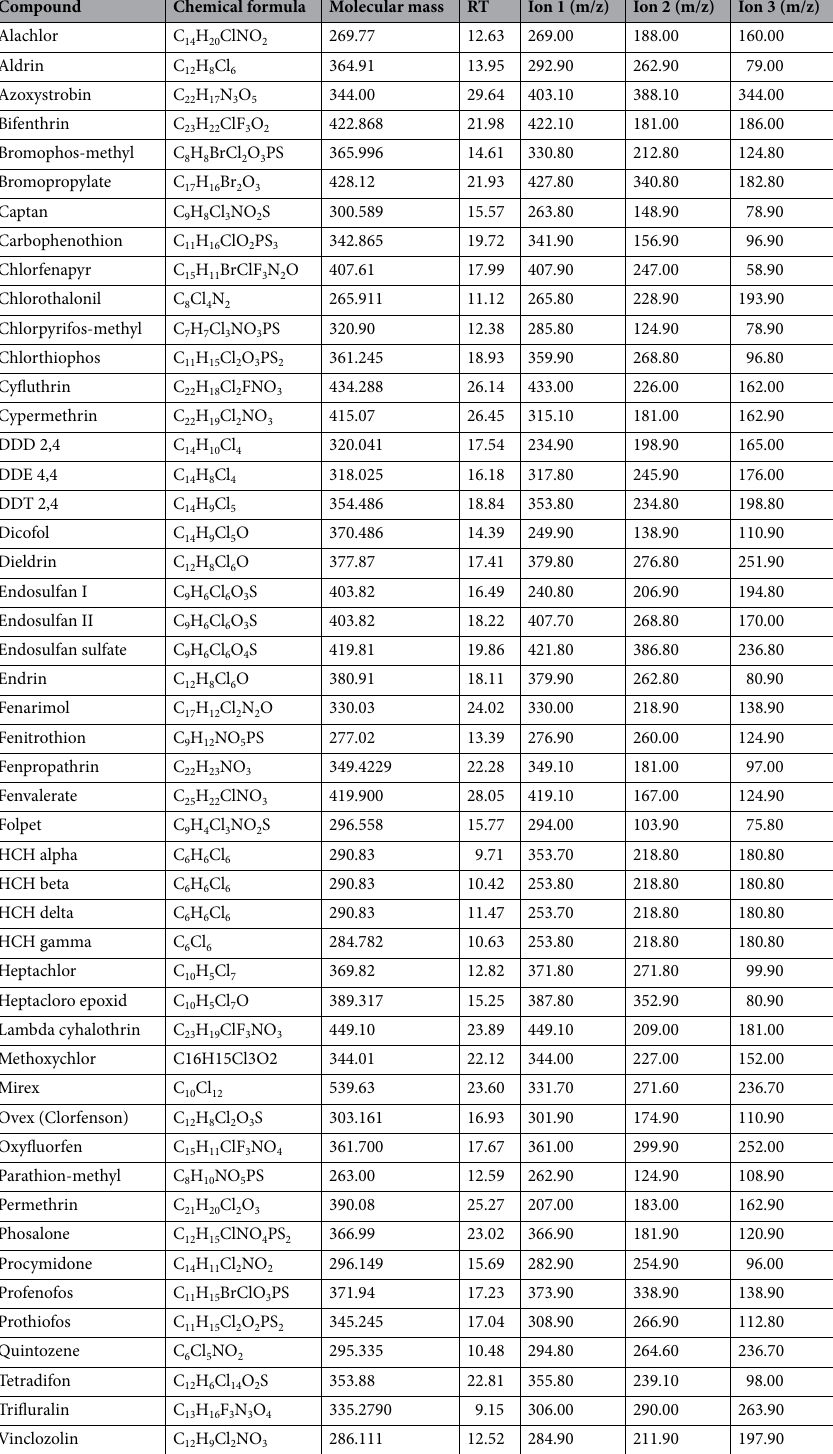
Table 1. Chemical formula, molecular mass, retention time (RT), and detection ions (m/z) of the compounds analyzed via gas chromatography coupled with mass spectrometry